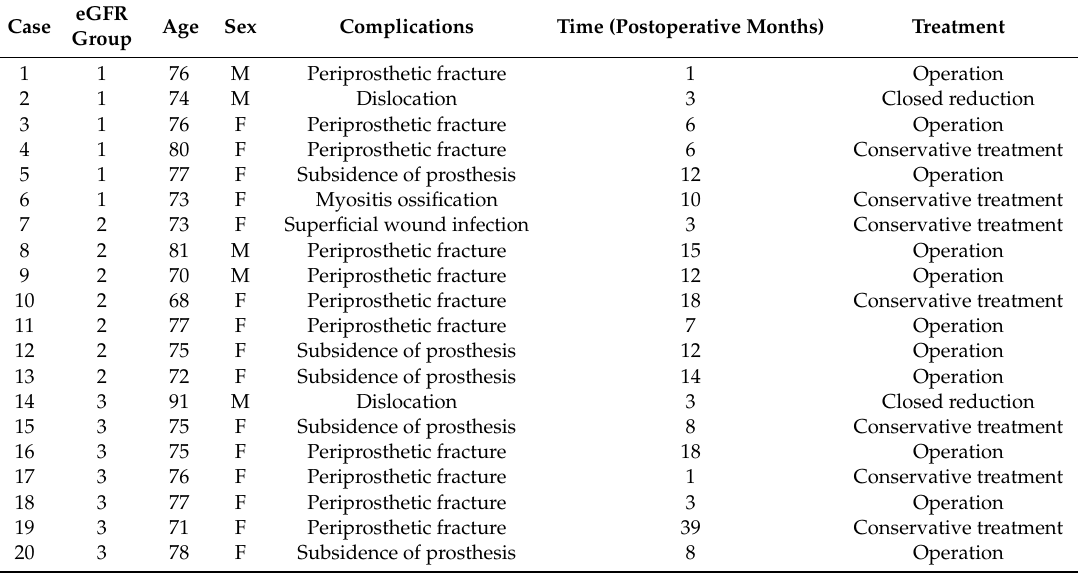
Table 3. Surgical